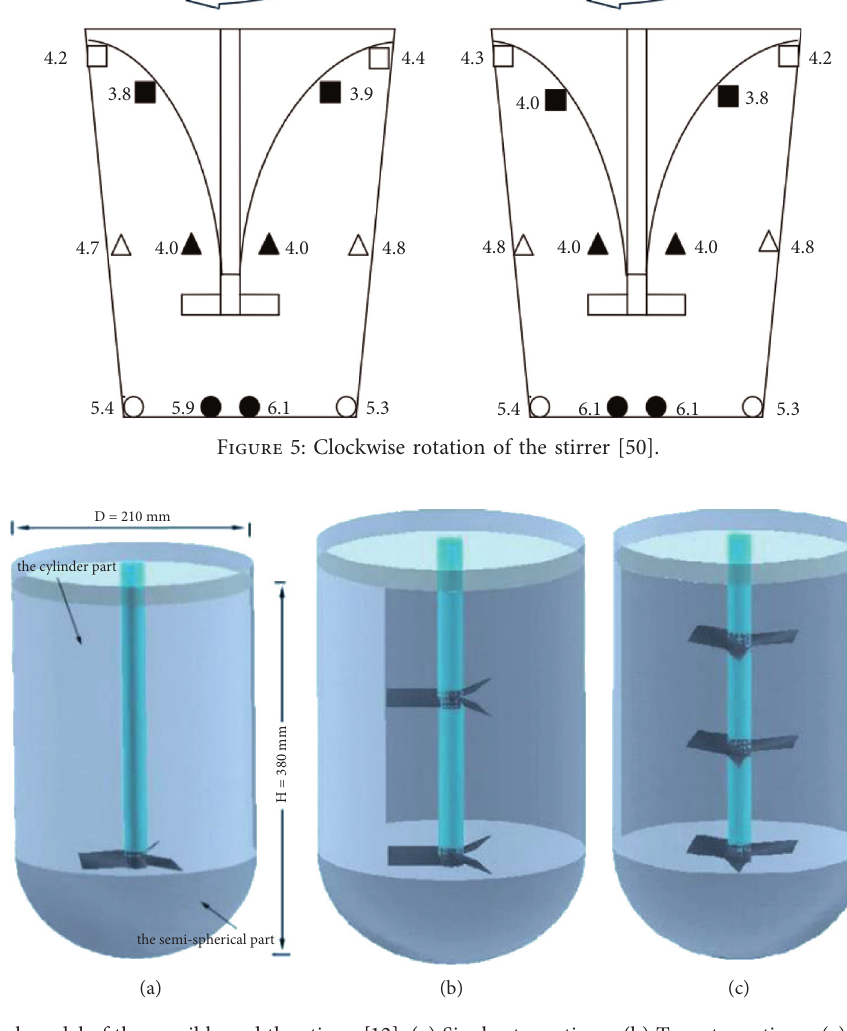
Figure 6: Geometrical model of the crucible and the stirrer [12]. (a) Single-stage stirrer. (b) Two-stage stirrer. (c) The multi-stage stirrer.